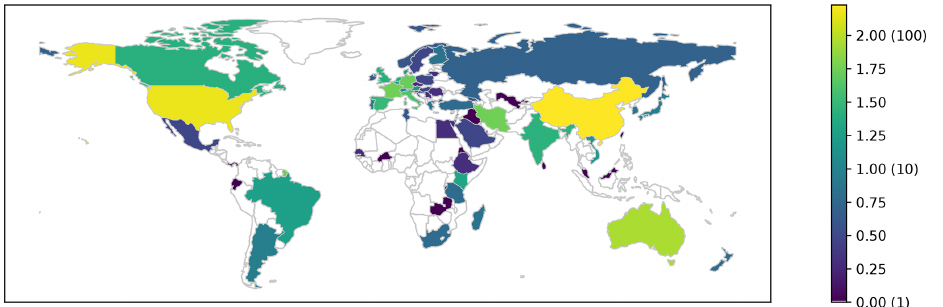
Figure 4. Total number (log 10 ) of institutions per country that participated in articles included in this review. Numbers between brackets are the real number of publications. Outlined countries have zero occurrences.